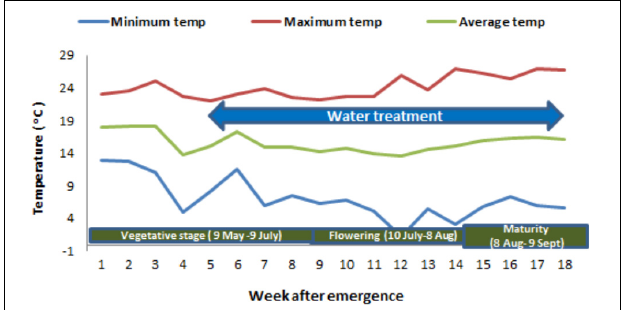
FIGURE 2 | Weekly mean maximum, minimum and average temperature ( ◦ C) during different stages of African turnip weed.